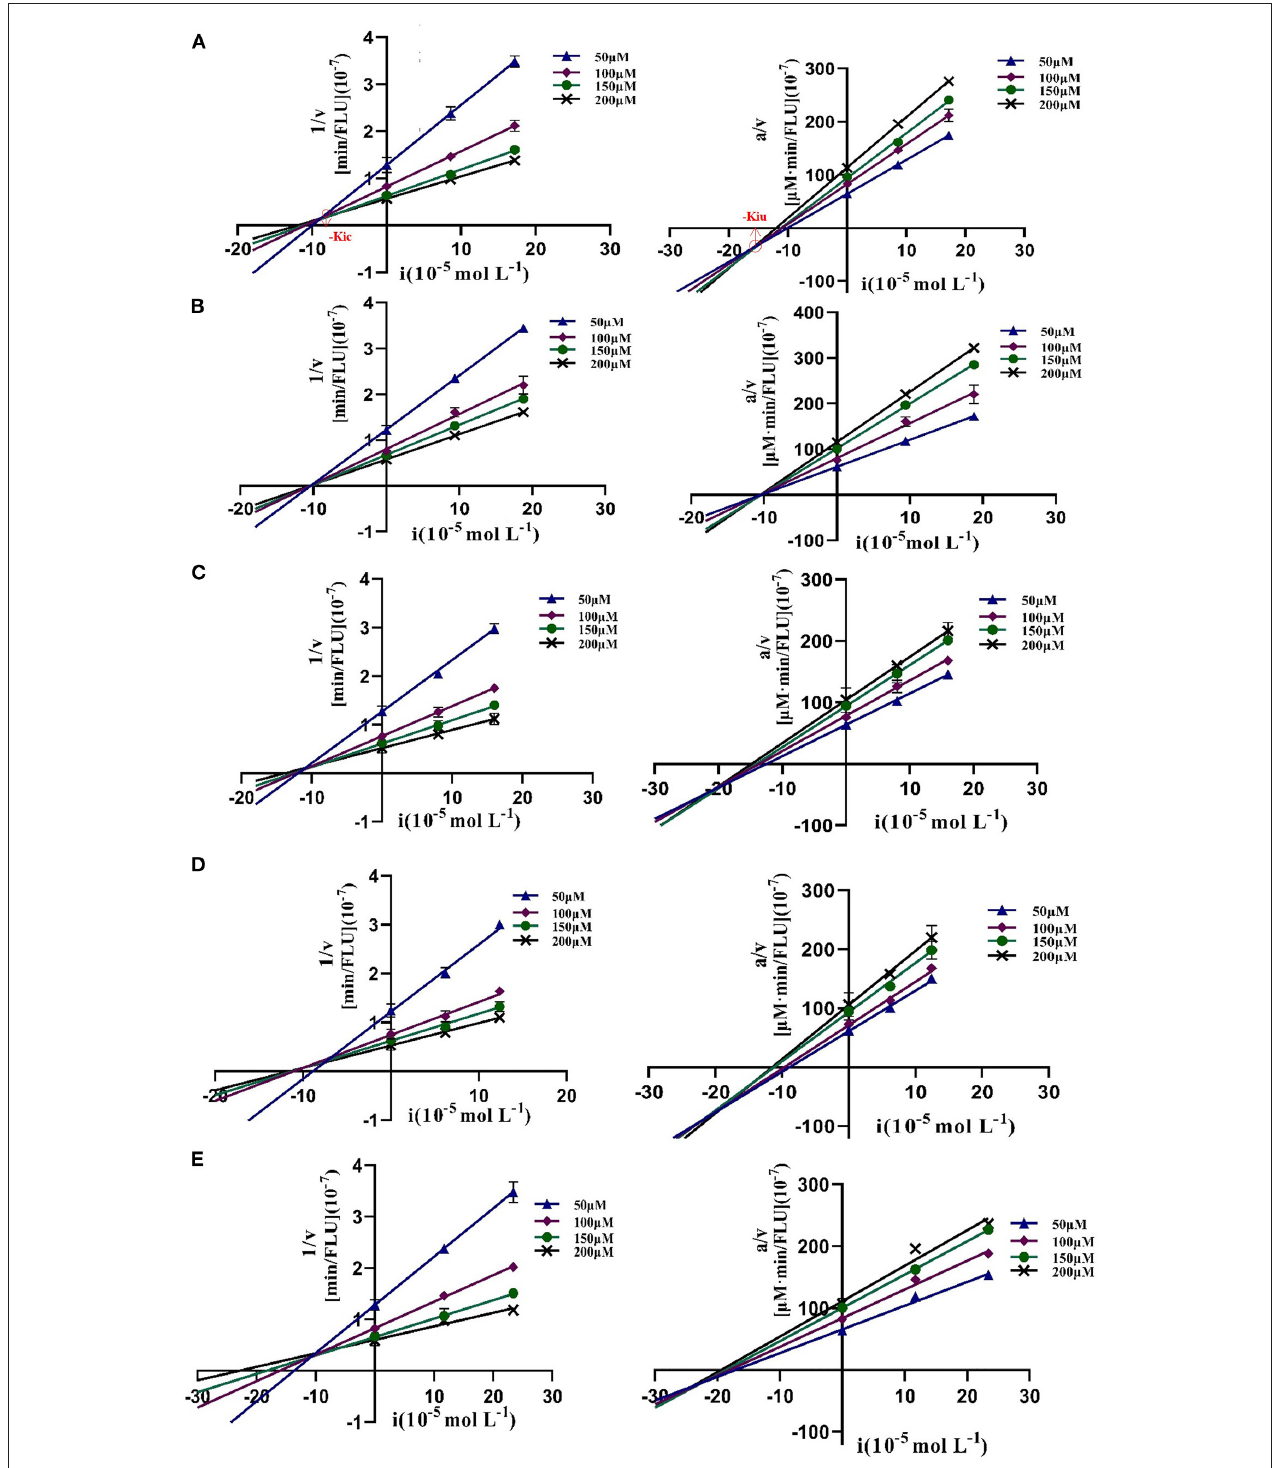
FIGURE 3 | Dixon and Cornish-Bowden plots of DPP-4 inhibition by hyperoside (A) , myricetin (B) , narcissoside (C) , cyanidin 3-O-glucoside (D) , isoliquiritigenin (E) .